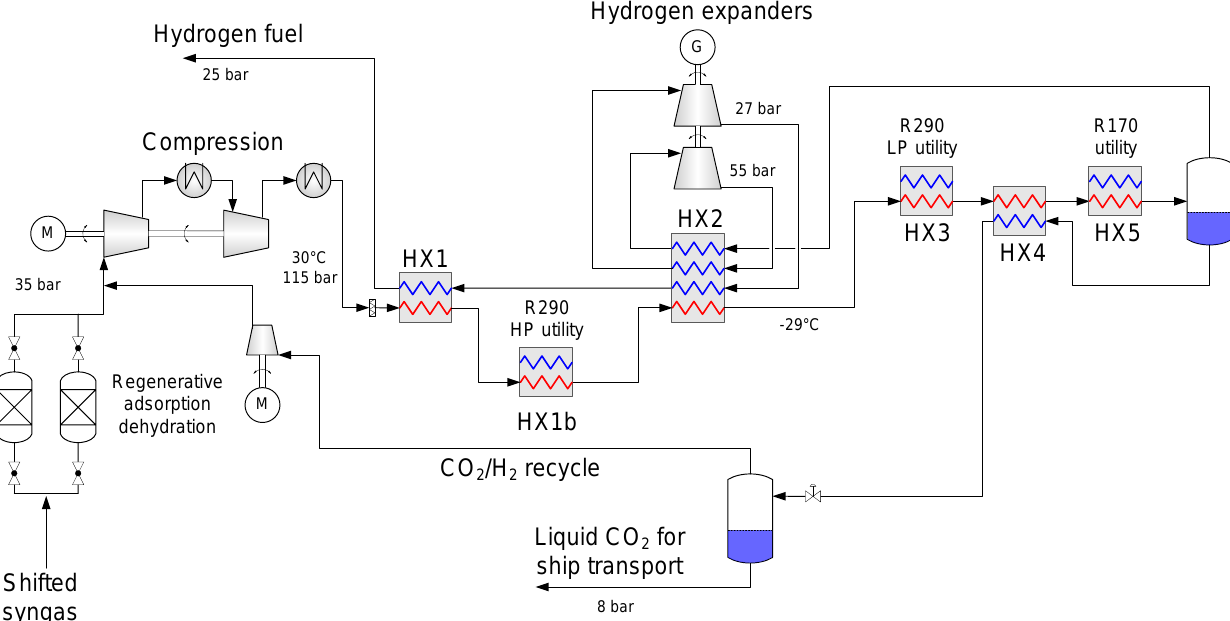
Figure 13. Process flow diagram for the low-temperature capture unit producing liquid CO 2 for ship transport.